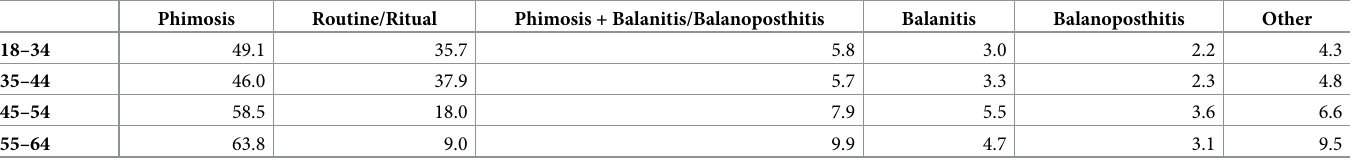
Values may not add up to 100 due to rounding